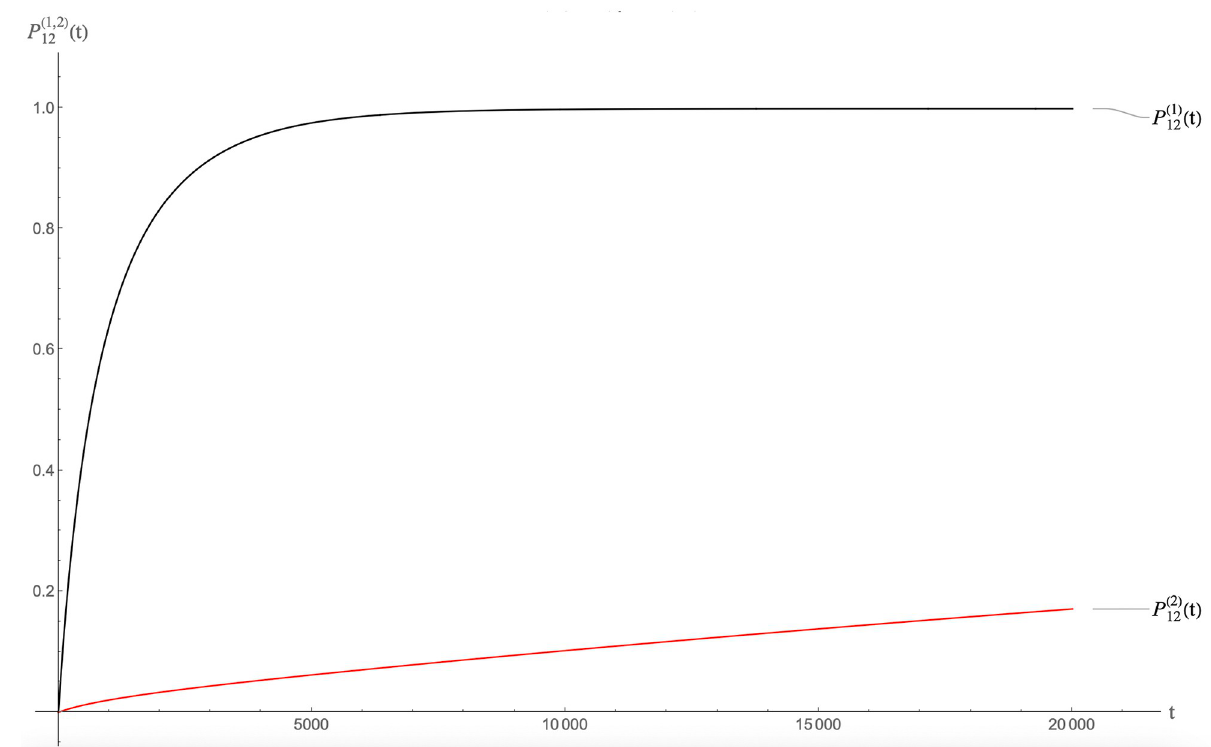
Fig 15. Packaging competition for c 0 = 4.0. The other parameters are the same as for Fig 10.